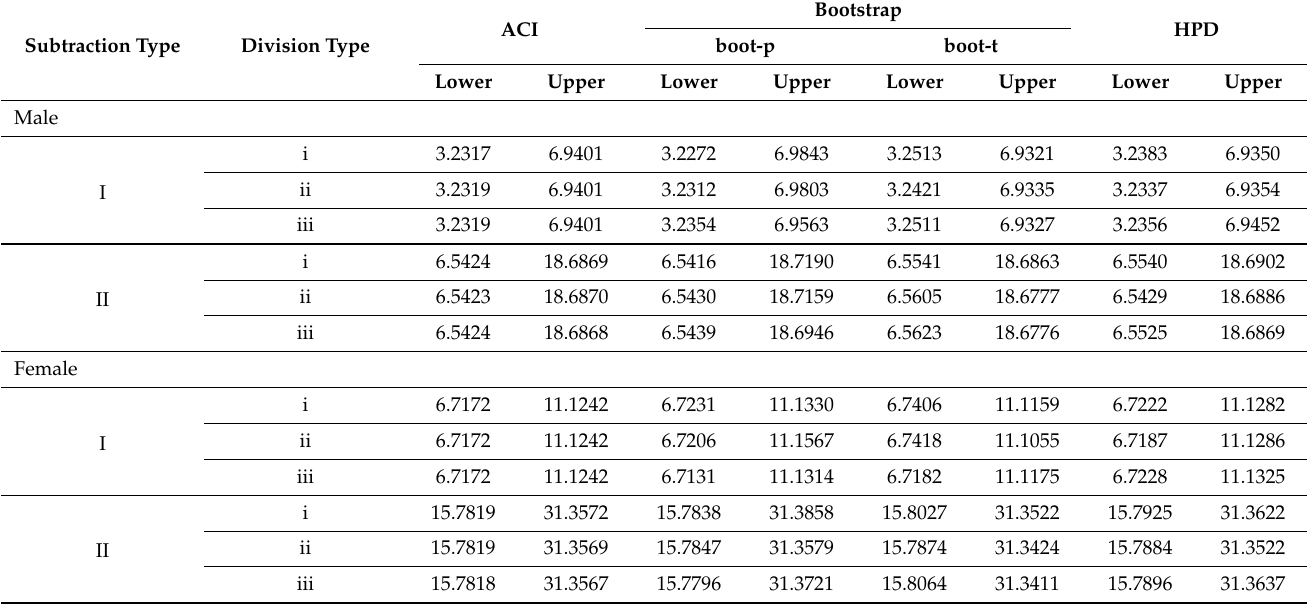
Table A11. The results of four intervals for λ at 90% confidence/credible